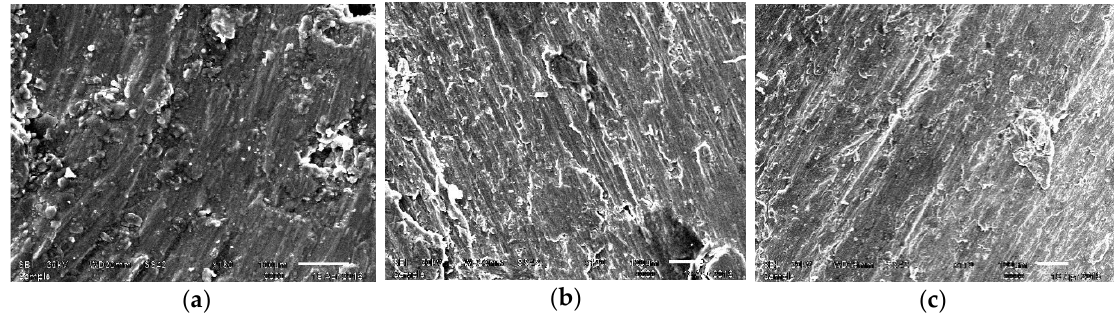
Figure 2. ( a ) Scanning electron microscopy (SEM) micrograph of specimen A ( b ) SEM micrograph of specimen B ( c ) SEM micrograph of specimen C.